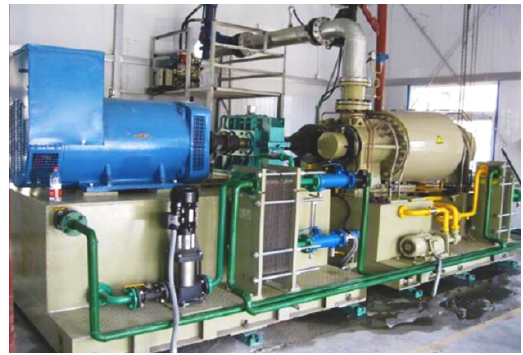
Figure 12. The screw generator set in Yangyi Tibet, China.